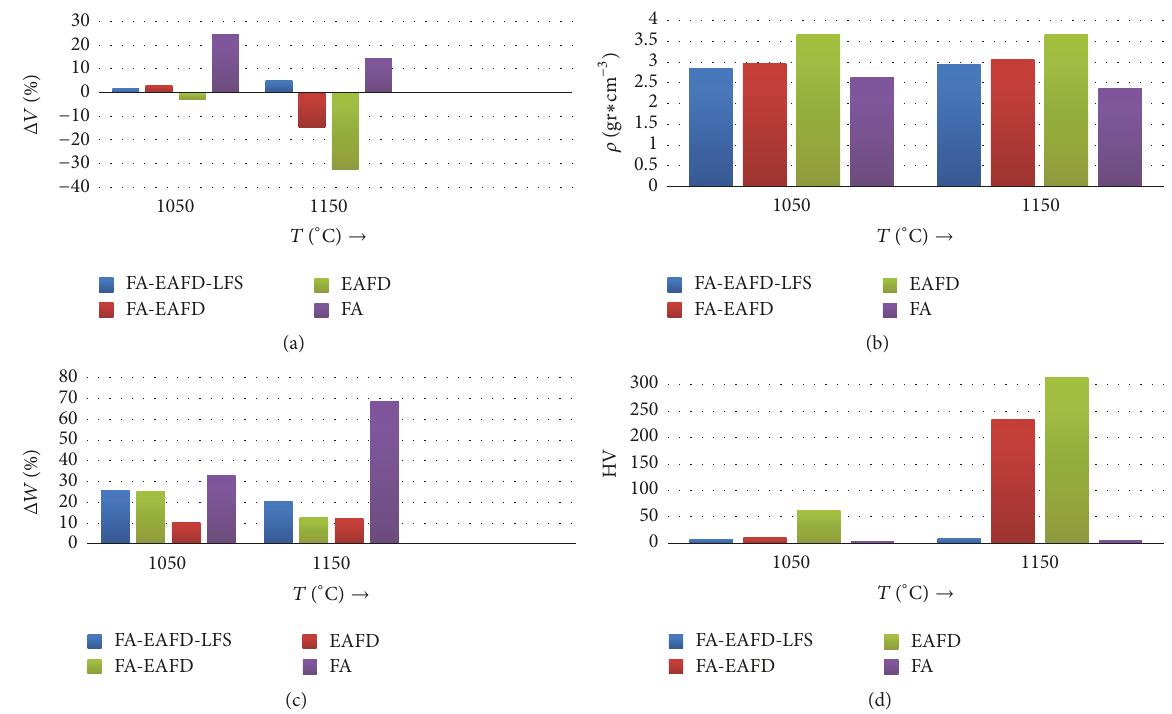
Figure 6: Volume change (a), apparent density (b), water absorption (c), and Vickers microhardness (d), for all the samples produced in this